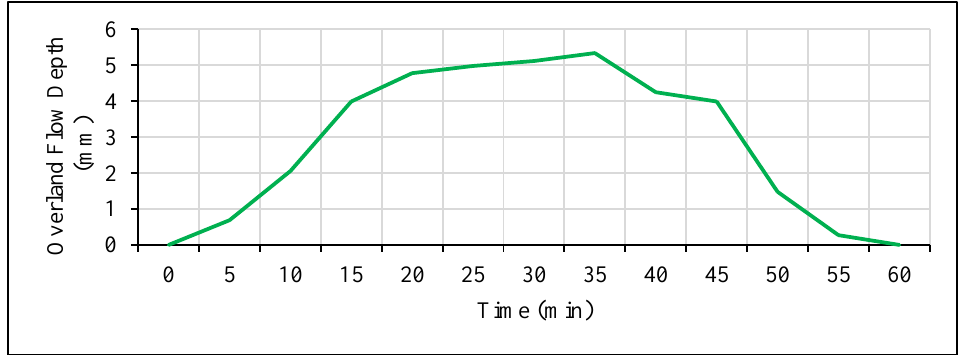
Figure 10. Overland flow hydrograph for rainfall intensity of 100 mm/h for 30 min.